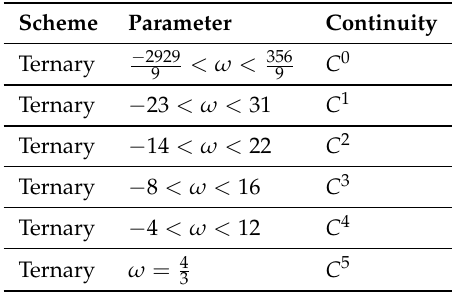
Table 5. Continuity order of ternary scheme (Equation